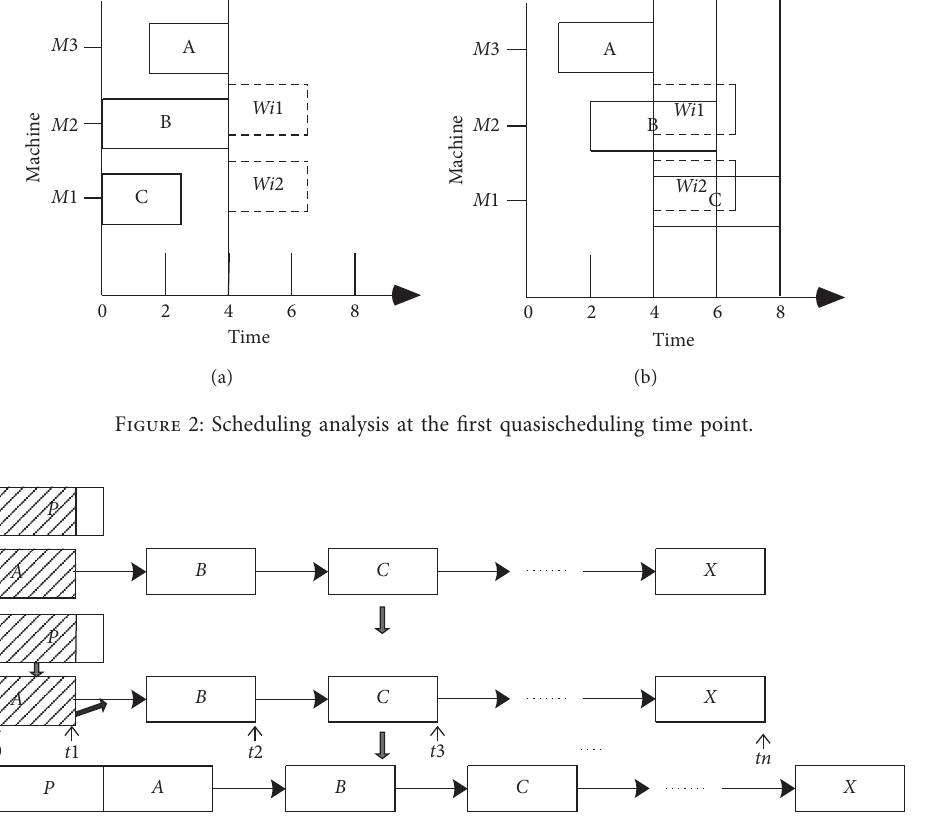
Figure 3: A schematic diagram of the backshift of the process affected by scheduling at the first “quasischeduling time point.”